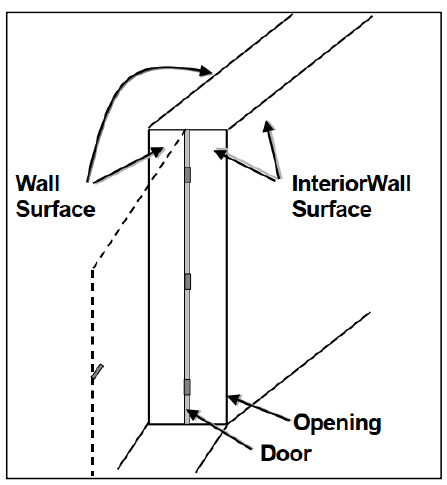
Figure 7. Classification of Openings (Source: ref.